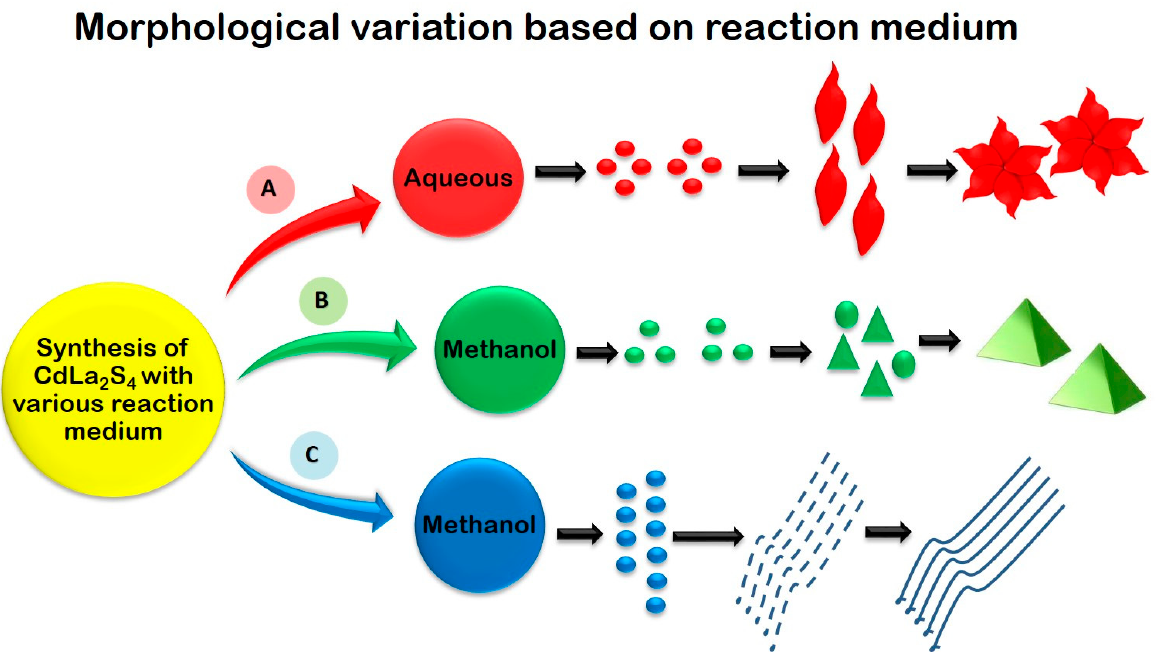
Figure 7. Schematic representation of various morphologies of CdLn 2 S 4 obtained by controlling the reaction medium and their corresponding concentration. Figure adapted from [74].